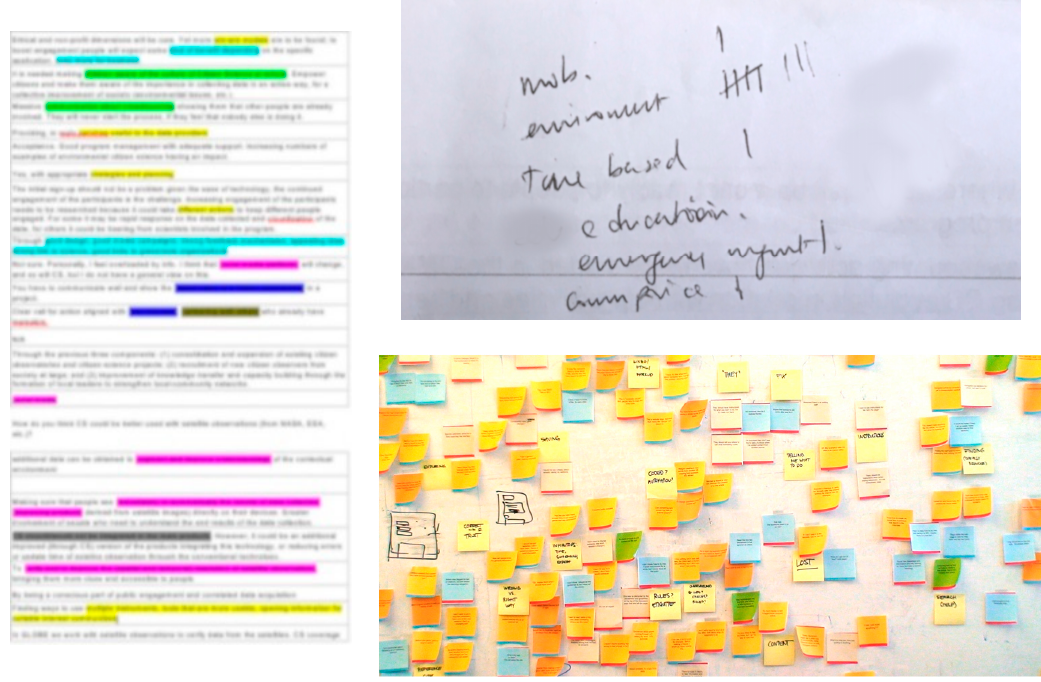
Figure 1. Analysis of stakeholder responses: ( left ) Following identification of categories based on an analysis of survey responses, each participant feedback is encoded with a relevant category—image blurred to preserve anonymity of responders; ( right-top ) hand-written notes helped summarise category counts based on survey responses; and ( right-bottom ) an example affinity diagram—image from [58].